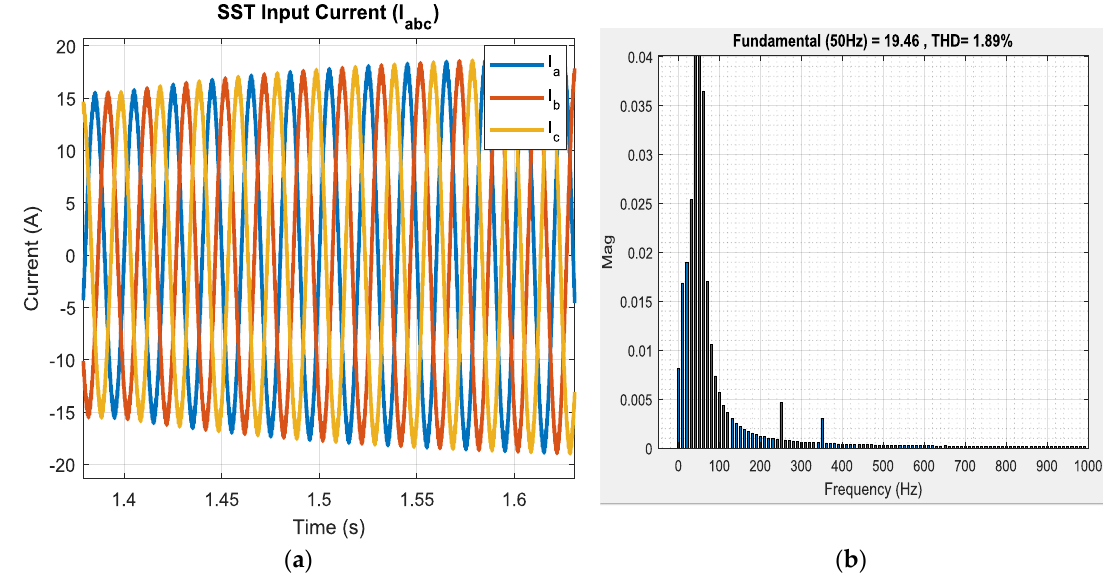
Figure 31. ( a ) SST input current at the grid side. ( b ) THD analysis of the phase A input